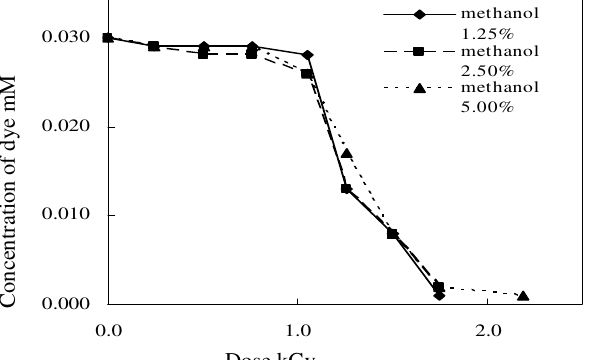
Figure 2. Radiolytic degradation of 0.01, 0.02 and 0.03 mM congo red dye solutions in 5 % aqueous methanol.